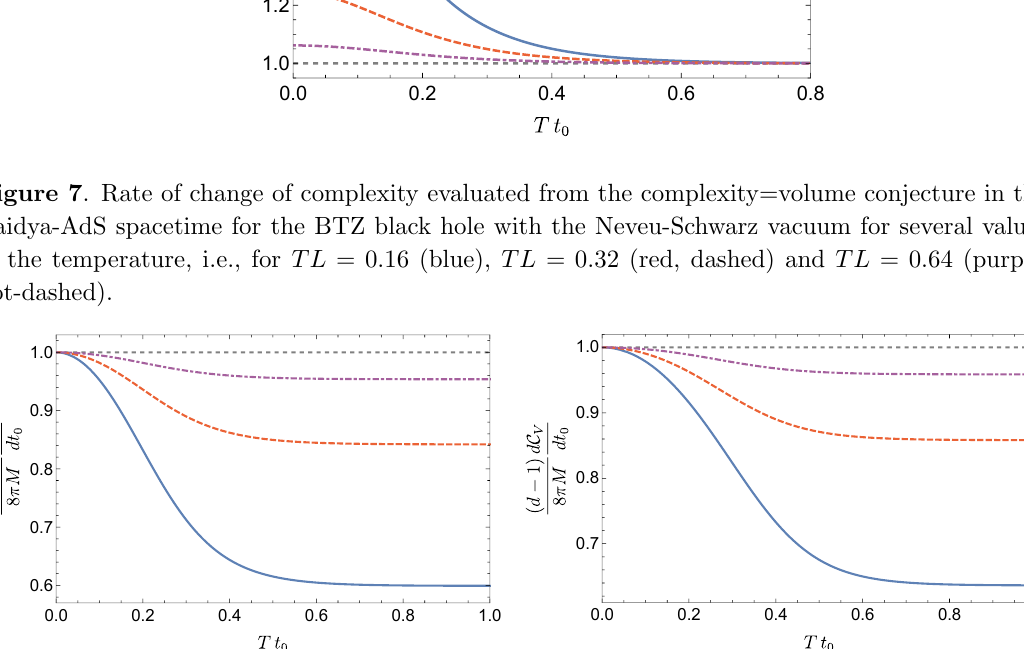
Figure 8 . Rate of change of complexity evaluated from the complexity=volume conjecture in the spherical ( k = 1) Vaidya-AdS spacetime in d = 3 (left) for TL = 0 : 32 (blue), TL = 0 : 52 (red, dashed) and TL = 0 : 98 (purple, dot-dashed) and d = 4 (right) for TL = 0 : 48 (blue), TL = 0 : 72 (red, dashed) and TL = 1 : 32 (purple,